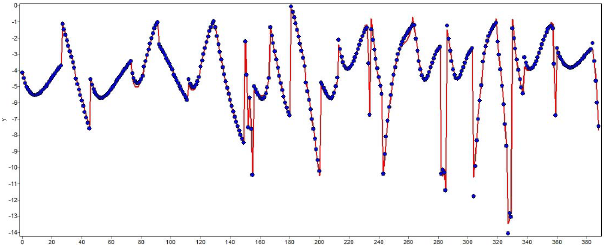
Figure 16. The fitting curve of Eq. (21) ( x 4 ).